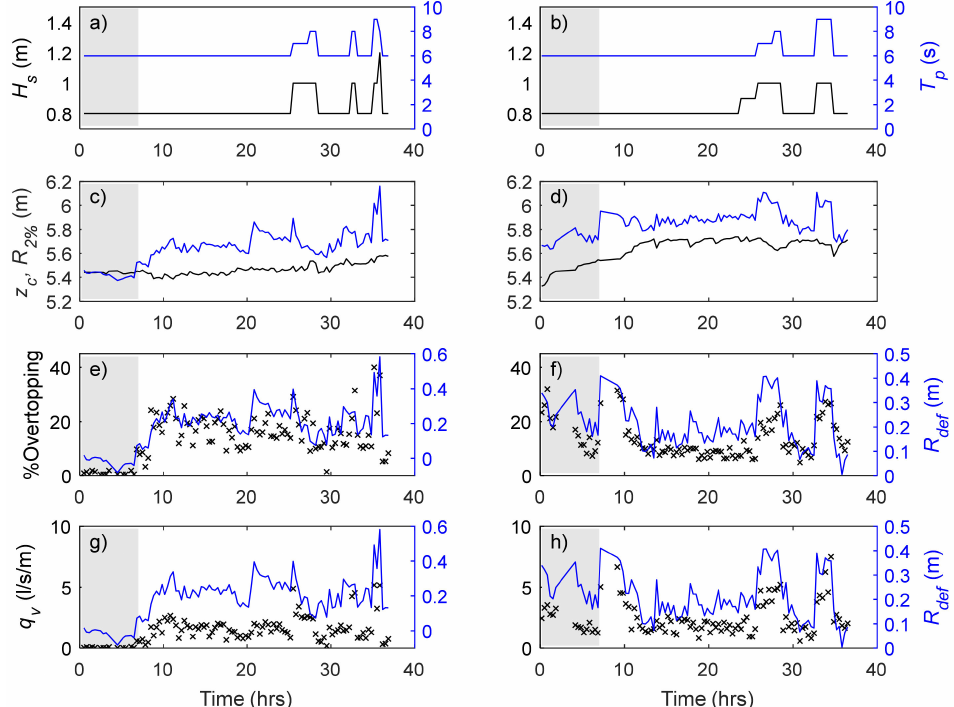
Figure 2. Timeseries of wave, morphology and overtopping data during each 20 min segment (see Section 2.2) for 1DR ( left ) and 2DR ( right ). ( a , b ) Significant wave height (primary x -axis, black) and peak wave period (secondary y -axis, blue). ( c , d ) Crest elevation z c (black) and predicted runup elevation R 2 % (blue). ( e , f ) Percentage of swash events which overtopped the revetment crest (primary axis, black) and deficit in freeboard (secondary axis, blue). ( g , h ) Overtopping discharge q v (primary axis, black) and deficit in freeboard R def (secondary axis, blue). The grey box indicates the period for which z WL = 4.8 m, at all other times z WL = 4.9